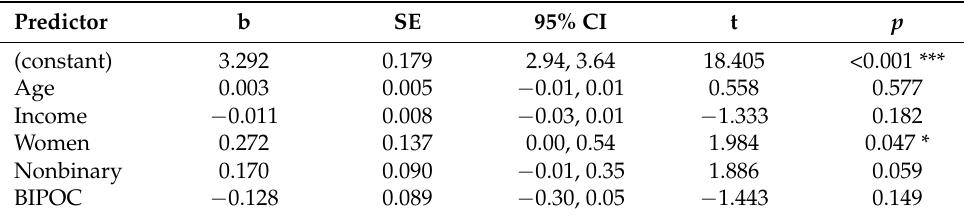
Table 3. Predicting COVID-19 impact by demographics.